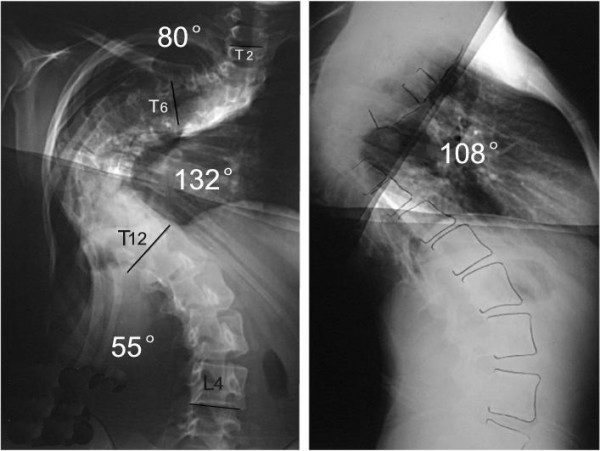
M, 21Y, Idiopathic kyphoscoliosis.